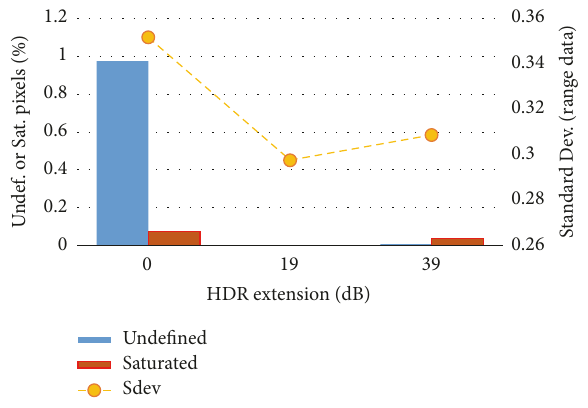
Figure 20: Quality parameters for R1 with HDRE-I and GLT, 𝑃 = 0.5 .